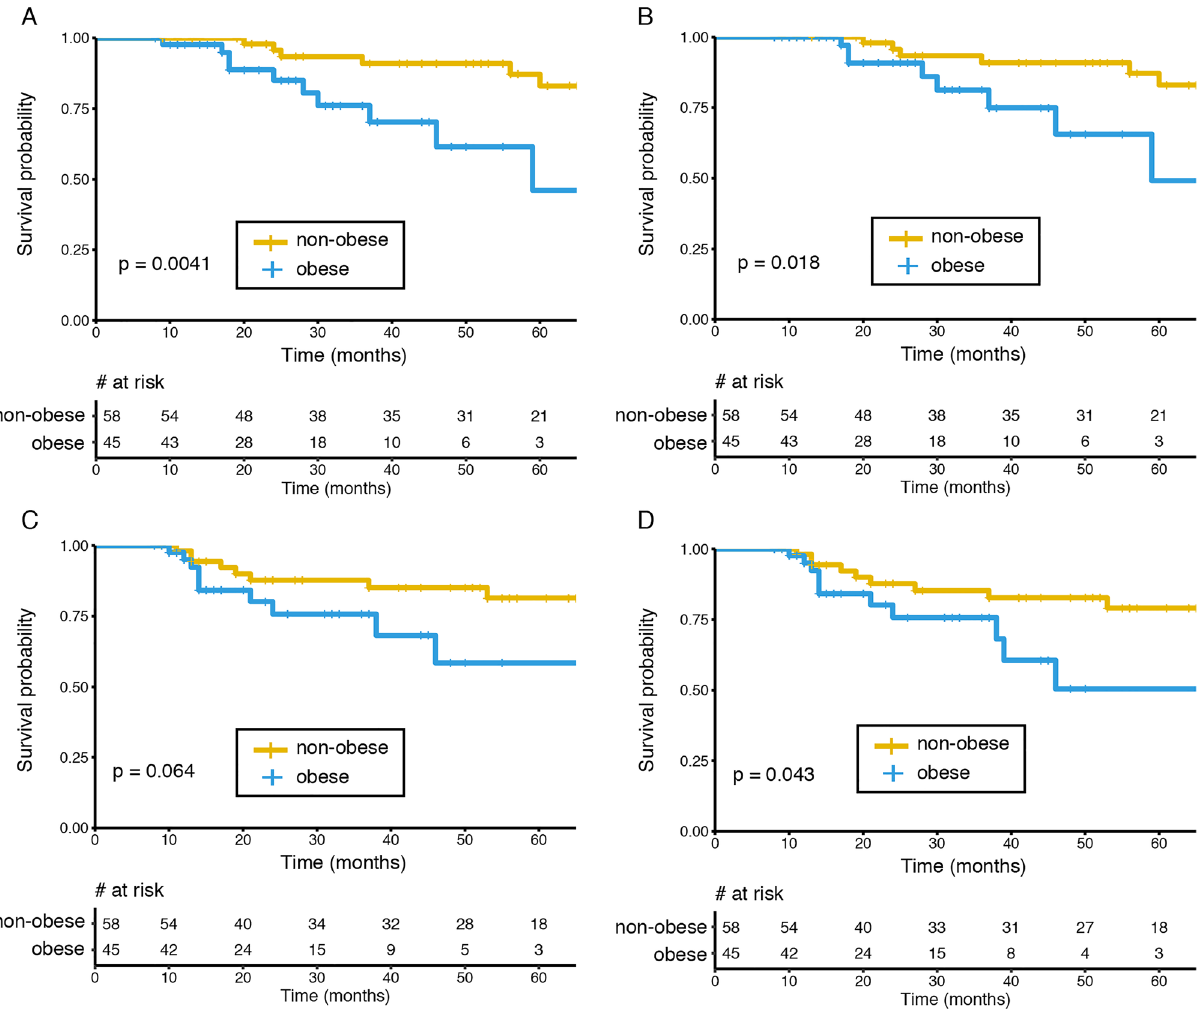
Figure 2. Obesity is associated with poorer survival in stage III patients. ( A ) OS curves comparing non-obese versus obese (LogRank p = 0.0041). ( B ) BCSS curves comparing non-obese versus obese (LogRank p = 0.018). ( C ) DDFS curves comparing non-obese versus obese (LogRank p = 0.064). ( D ) IDFS curves comparing non- obese versus obese (LogRank p =